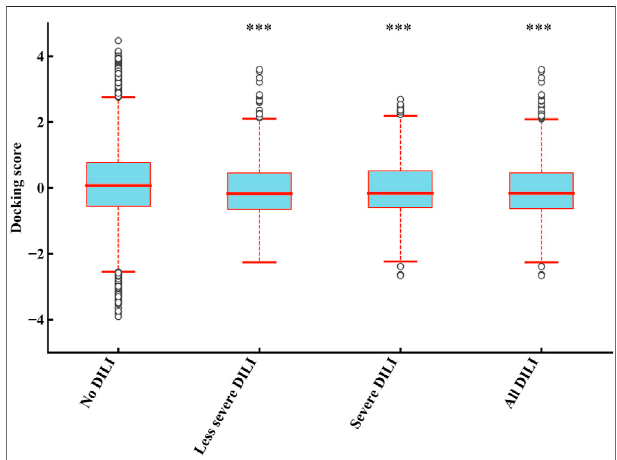
FIGURE6| Comparisonofresultsof fi vemitochondrialproteins(PDBID: 3B96, 5FS8, 4FDH, 5G5J, and 6G2M) binding between DILI groups and no DILI group (KIs were not included). The docking scores of “ less severe DILI, ” “ severe DILI, ” and “ all DILI ” were signi fi cantly lower than those of “ no DILI ” group (Kruskal – Wallis test). *** p <